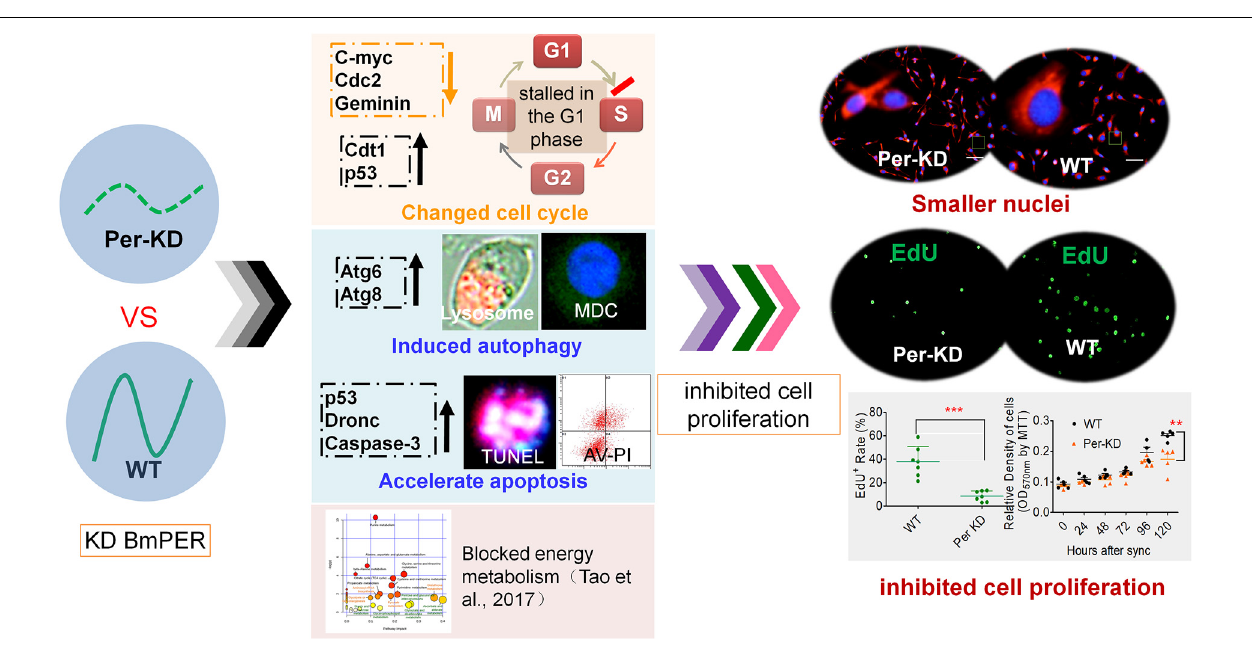
FIGURE 8 | A proposed mechanism of inhibition of the cell cycle associated with knockdown of BmPer expression. Knockdown of the BmPer gene causes cell cycle deceleration, increased autophagy and apoptosis, or other previously reported changes in cellular metabolism (Tao et al., 2017), ultimately lead to cell shrinkage and inhibition of cell